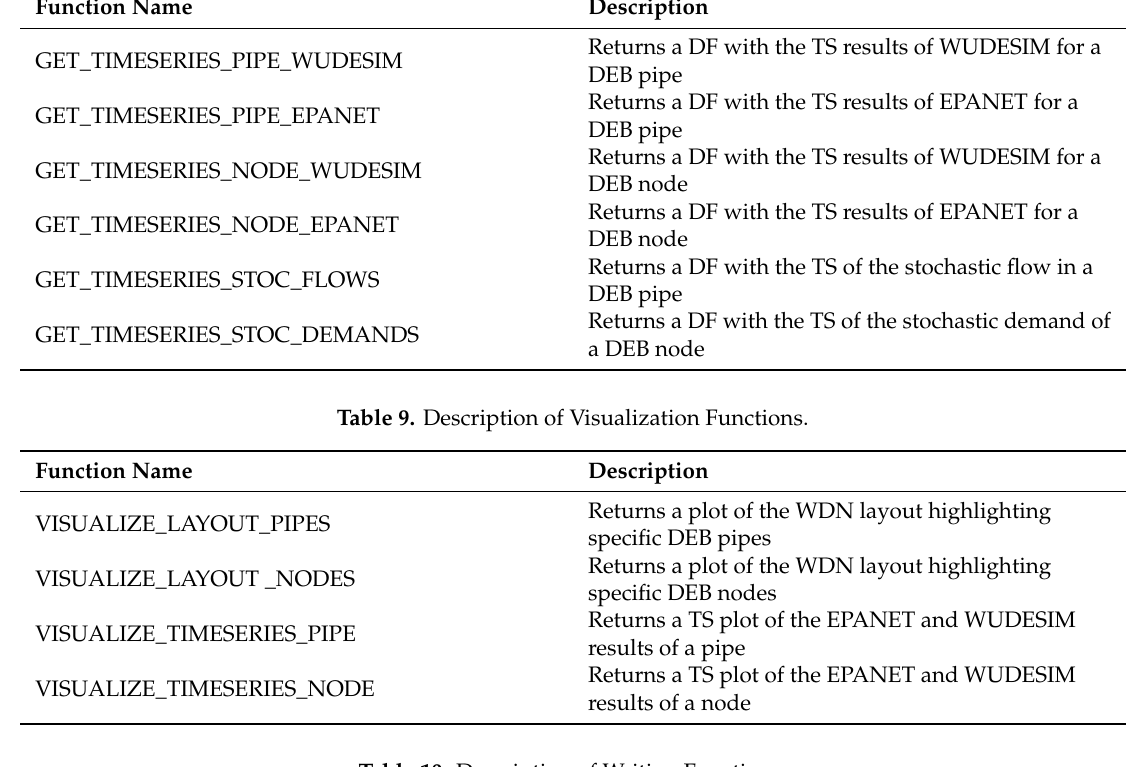
Table 10. Description of Writing